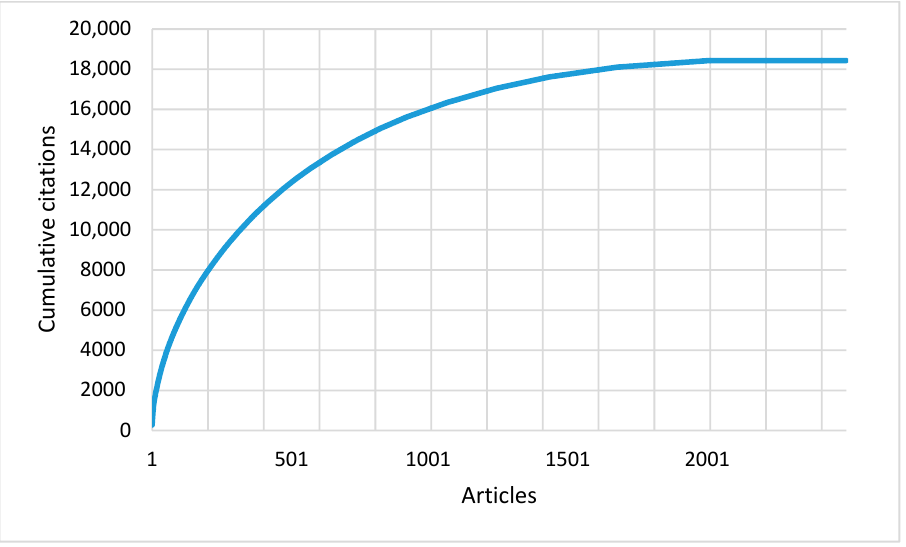
Figure 2. Distribution of the article citations ( n = 18,431).